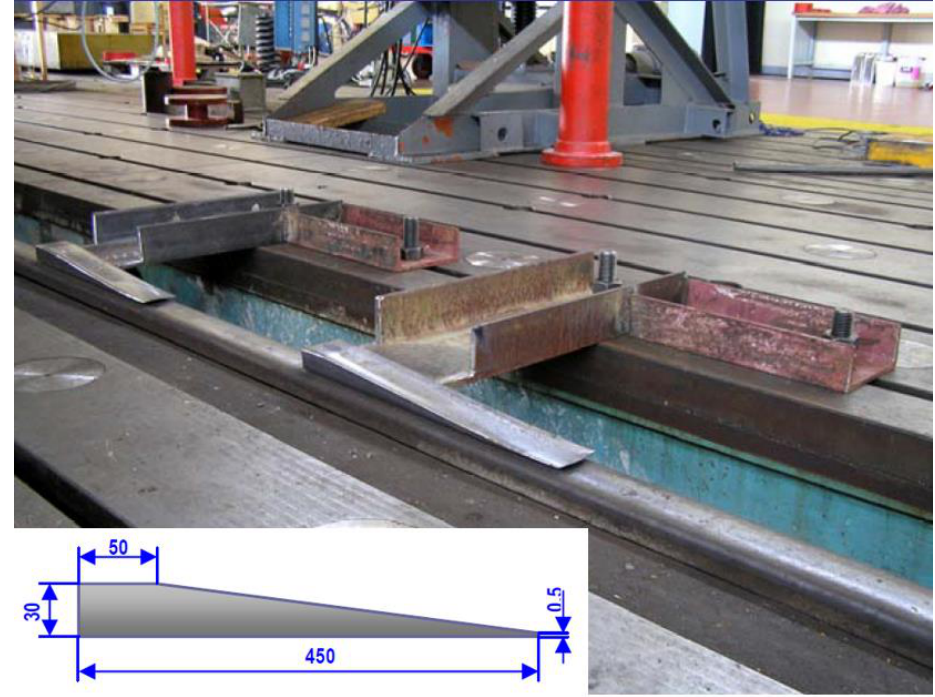
Figure 5. Wedge locations at rail.